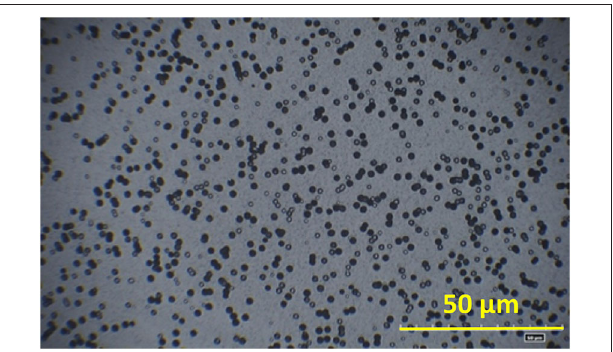
FIGURE 3 | Example of CR39 showing α -particle tracks at the optical microscope after 30min etching. This corresponds to a shot with CH + BN pitcher-catcher geometry with a 2-mm thick BN slab. This CR39 sample was facing the catcher rear surface, at an angle of 26 ◦ from the target normal and a detection distance of about 36cm. The detector was covered with a 30 µ m Al foil to stop low energy particles, thus providing a detection threshold energy of 6.4 MeV for α -particles. In this shot, the TP spectrum showed the presence of protons with energy 0.5–2 MeV.